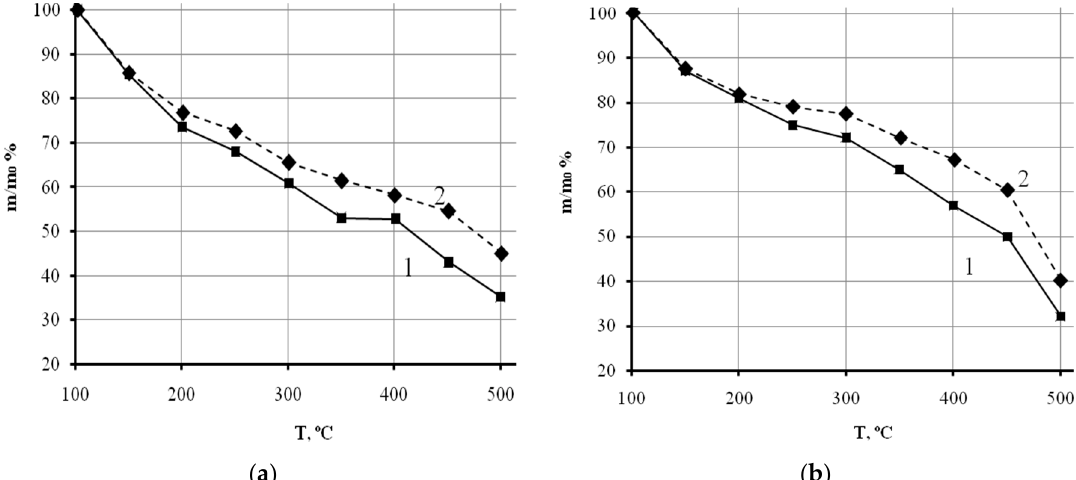
Figure 2. Mass losses of PBO (1) and PBO-F (2) polymer films formed from reaction solutions onto Si substrate ( a ) and mass losses of films of photoresist compositions based on PBO (1) and PBO-F (2) on an Si substrate ( b ). For the both cases the stepwise thermal treatment was up to 500 °C at 50 °C intervals and exposure for 15 min at each temperature.